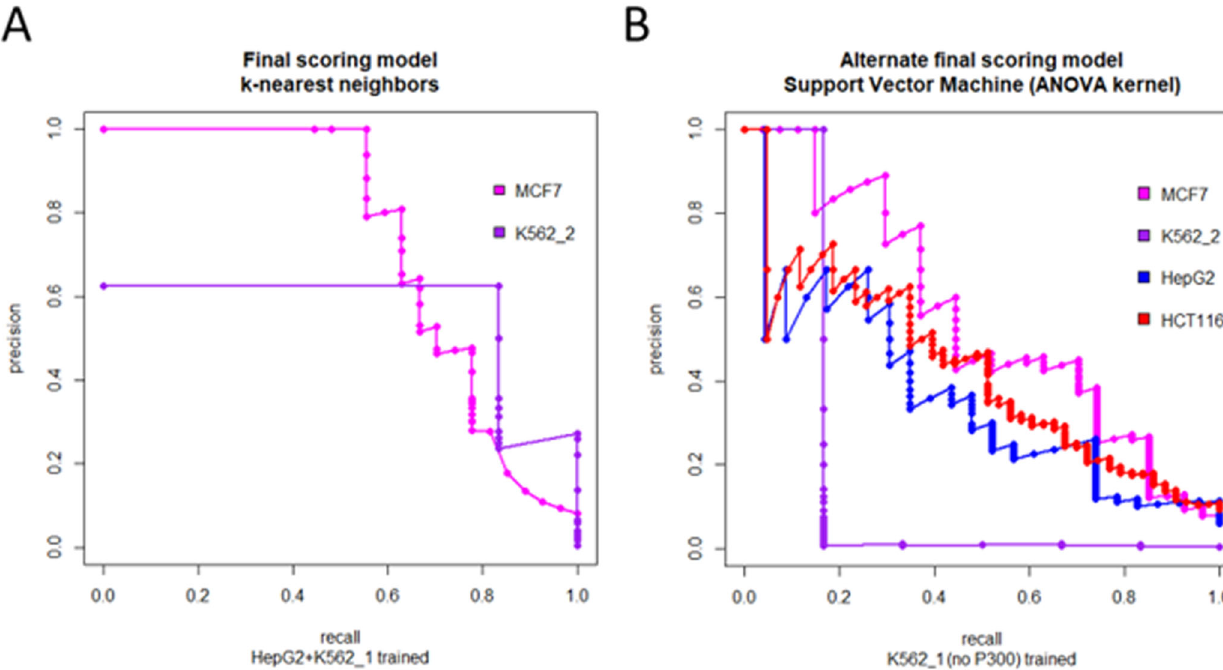
Fig. 2 Precision-recall curves of the best-performing models on test datasets. The precision-recall curve (PRC) is given for each model and all test sets available for that model. A PRCs for the best fi nal model (k-nearest neighbors) which was trained on the HepG2 + K562_1 joint dataset, evaluated on the MCF7 (AUPRC: 0.73) and K562_2 (AUPRC: 0.56) test datasets. B PRCs for the best alternate fi nal model (support vector machine with an ANOVA radial basis kernel), which was trained on the K562_1 set and tested on the MCF7 (AUPRC: 0.55), K562_2 (AUPRC: 0.17), HepG2 (AUPRC: 0.36), and HCT116 (AUPRC: 0.42) test datasets. This model was based on training data that did not include the P300 feature and is only suitable for scoring enhancer-gene links for which P300 data were